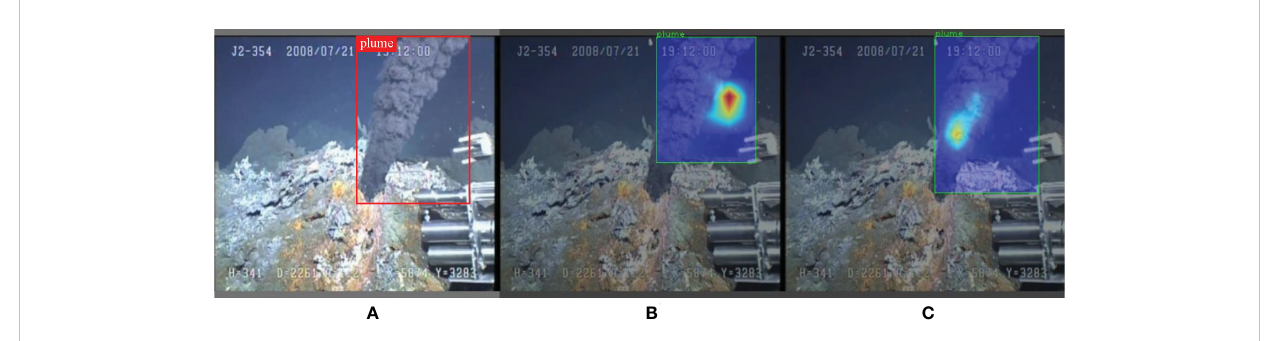
FIGURE 7 Grad-CAM visualization results. (A) The input image with ground truth marked. (B) The visualization result of baseline model (YOLOv5n). (C) The visualization result of CA-integrated model (YOLOv5n+CA).